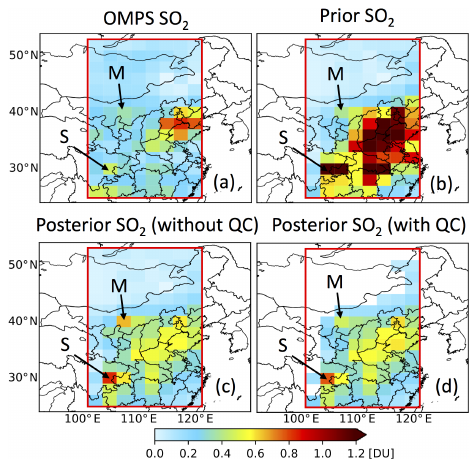
Figure 7. SO 2 VCD in October 2013 from OMPS (a) , prior GEOS- Chem simulation (b) , posterior GEOS-Chem simulation through the use of all OMPS data in the red box (c) , and posterior GEOS- Chem simulation through the use of only OMPS data that are in the grid cell where GEOS-Chem prior simulation of VCD is larger than 0.1DU. For posterior simulation, we only plot SO 2 VCD over grid cells where OMPS data are used to constrain emissions. M and S point to a grid cell in Inner Mongolia and the Sichuan Basin, re-